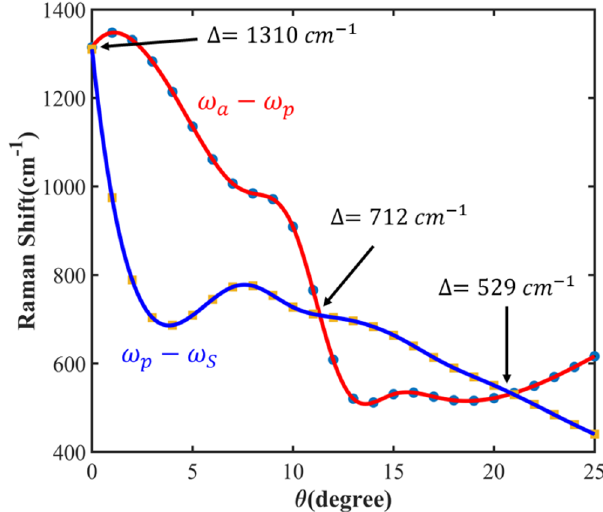
Fig. 8. Differences of resonance frequencies in function of the incidence angle. The crossing points correspond to ful fi lling the Raman resonance condition (1) for different Raman shifts indicated in the fi